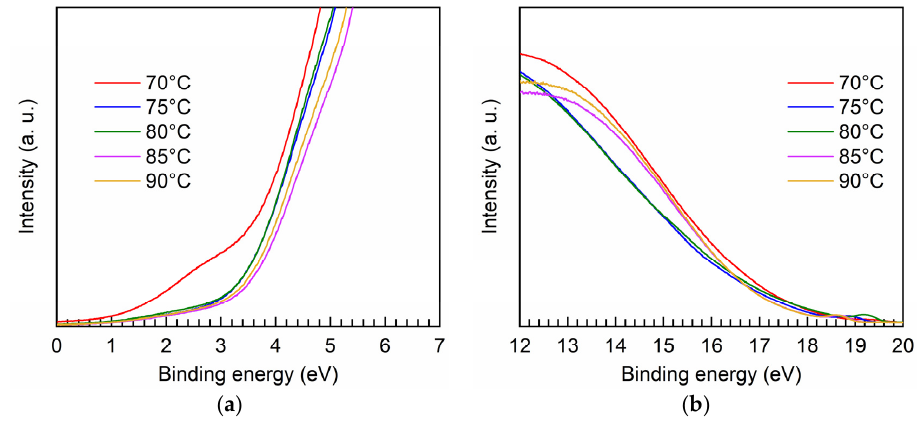
Figure 5. UPS spectra in the ( a ) low binding energy region and ( b ) high binding energy region for the PEALD Ta-doped TiO 2 films prepared at different bubbler temperatures. Table 2. Band gap, valance band position, and conduction band position for the PEALD Ta-doped TiO 2 films with different bubbler temperatures.